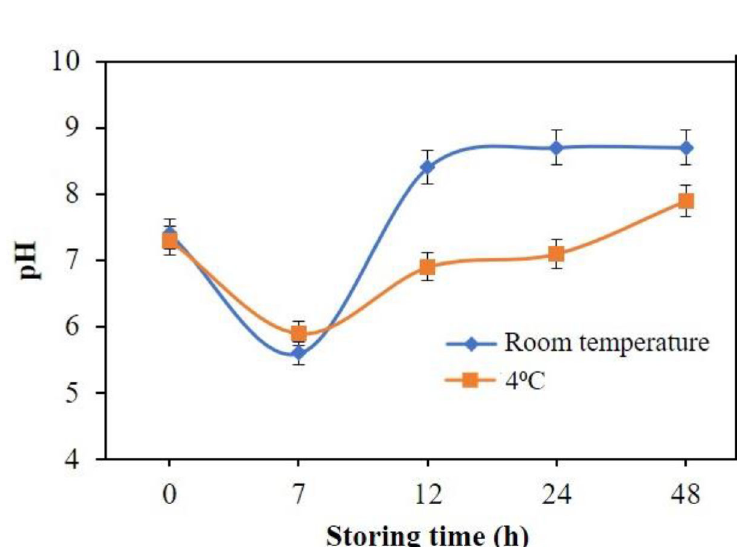
Figure 13. Lifetime of optical pH sensor.